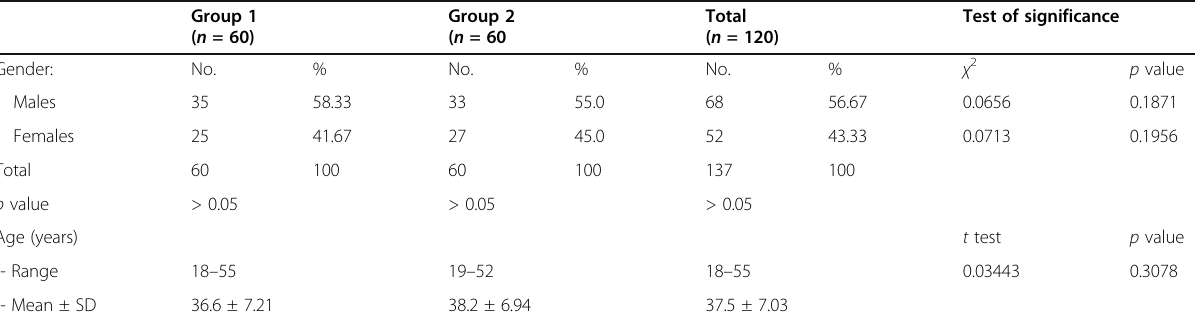
Table 2 Demographic data of our patients